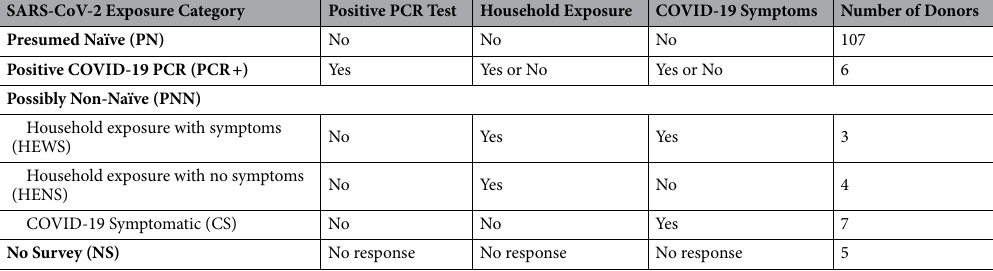
Table 1. Diagnosis, household exposure, and symptoms of SARS-CoV-2 infection among donors of self- collected finger-stick blood and saliva. Based on responses to anonymous surveys, study donors were classified into six